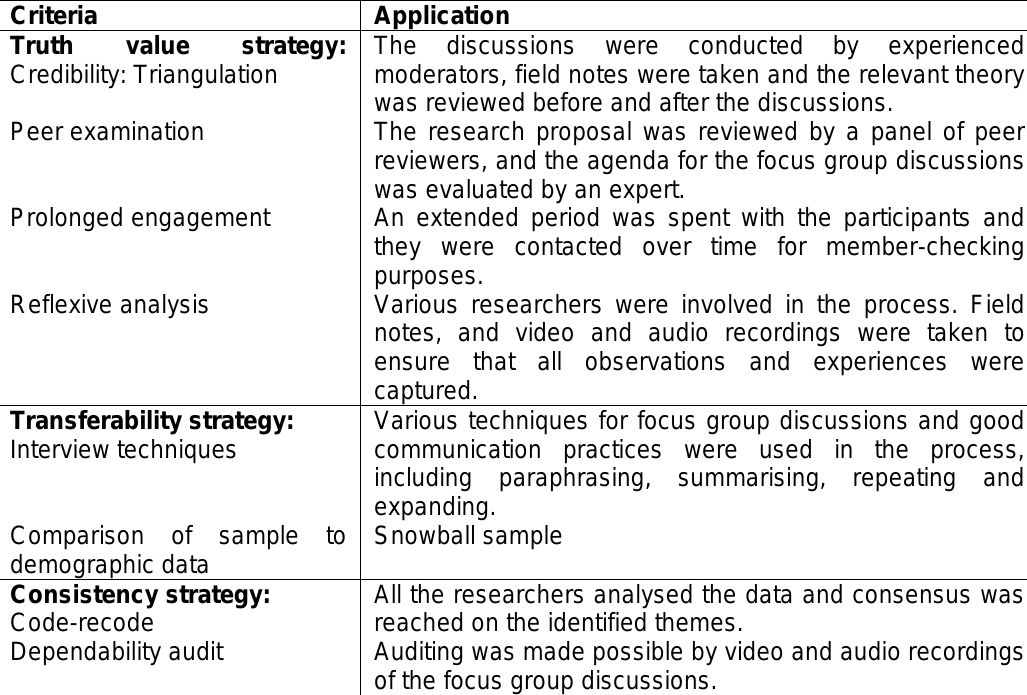
Table 2: Trustworthiness of the Study